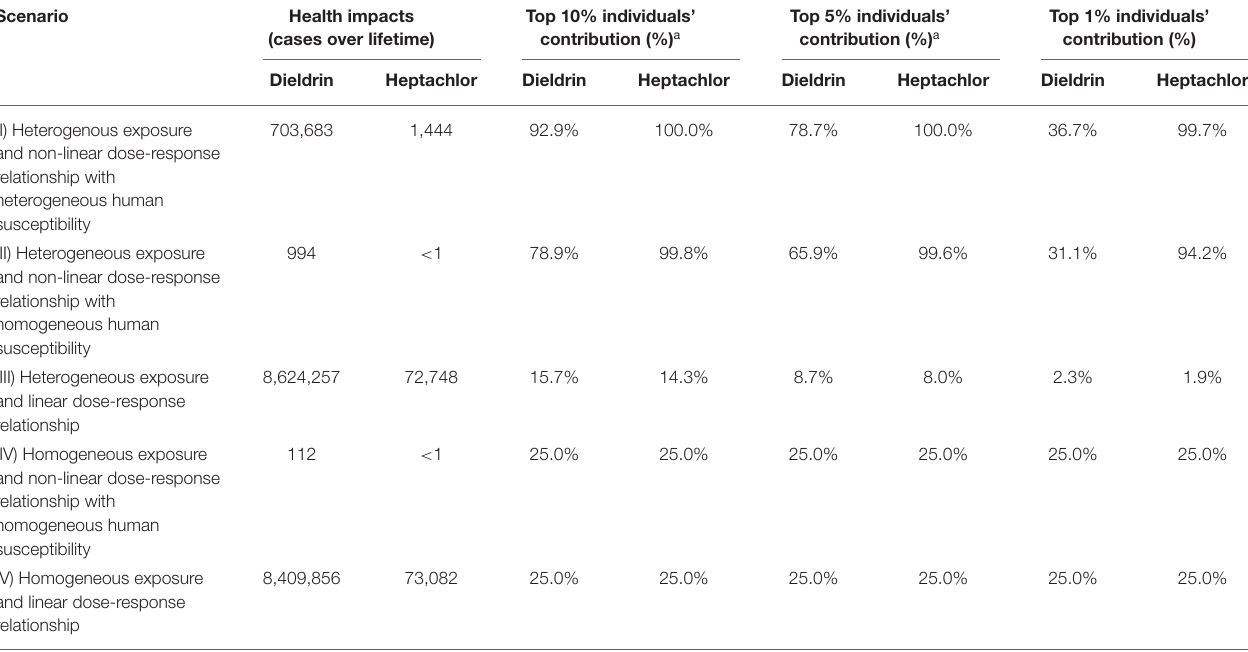
TABLE 4 | Overall health impacts estimated for the total population of the United States under five scenarios with the assumed emission rates in this